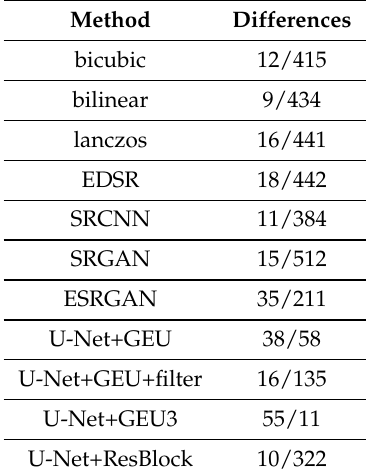
Table 5. Face recognition (FR) failed differences compared to the U-Net+GEU2